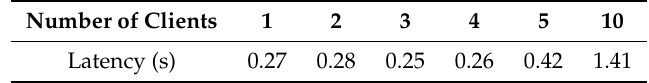
Table 1. Test results for Configuration 1: Video players in separate web clients.